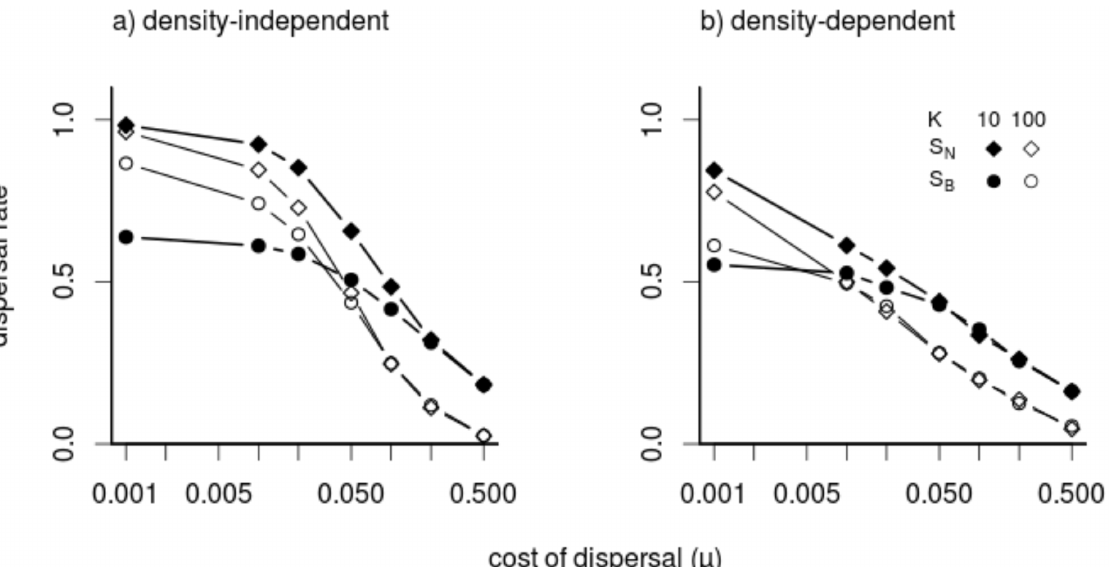
Fig 2. The effect of patch capacity K and dispersal strategy on evolved mean dispersal as a function of dispersal mortality, μ (log scale). (a) Density- independent ( DI ) scenario and (b) density-dependent ( DD ) scenario. Filled circles and diamonds represent small patches ( K = 10) and empty circles and diamonds big patches ( K = 100). Diamonds indicate natal dispersal ( S N ), circles breeding dispersal ( S B ). Other parameter values: environmental variability ( σ = K )) and fecundity ( λ =